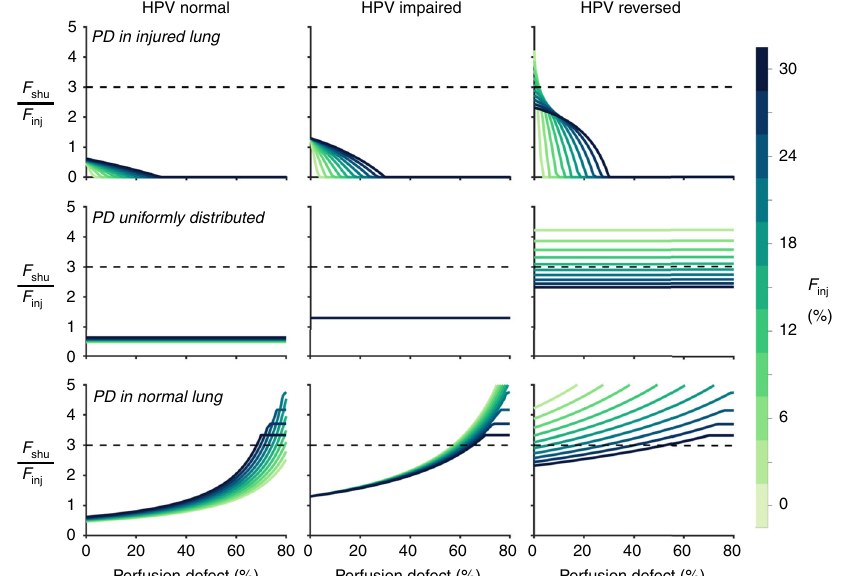
Fig. 4 Role of perfusion defects in injured and noninjured lung regions. In fl uence of perfusion defect (PD) on the ratio of shunt fraction ( F shu ) to injured fraction ( F inj ). Color re fl ects the fraction of injured lung, concentrated in the lower lung zone. Columns represent types of alterations to hypoxic pulmonary vasoconstriction (HPV). Rows represent types of perfusion defect distributions. Baseline perfusion gradient was 30%, and reversed HPV was modeled with 72% reduction of vascular resistance in injured regions. Dashed lines indicate F shu : F inj ratio of 3. Note that F inj = 0% is not explicitly